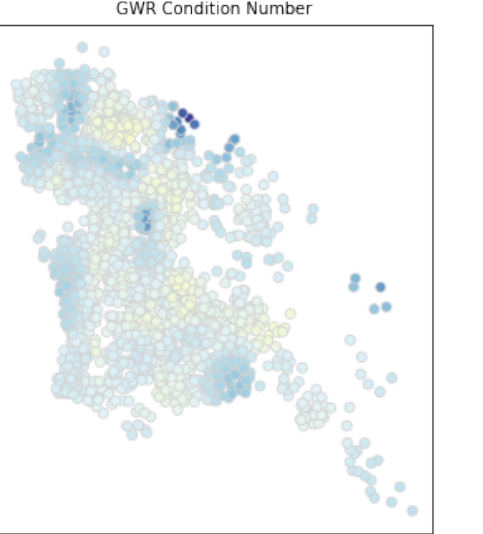
Figure 14. Local condition numbers for GWR ( left ) and MGWR ( right ) for the Berlin data